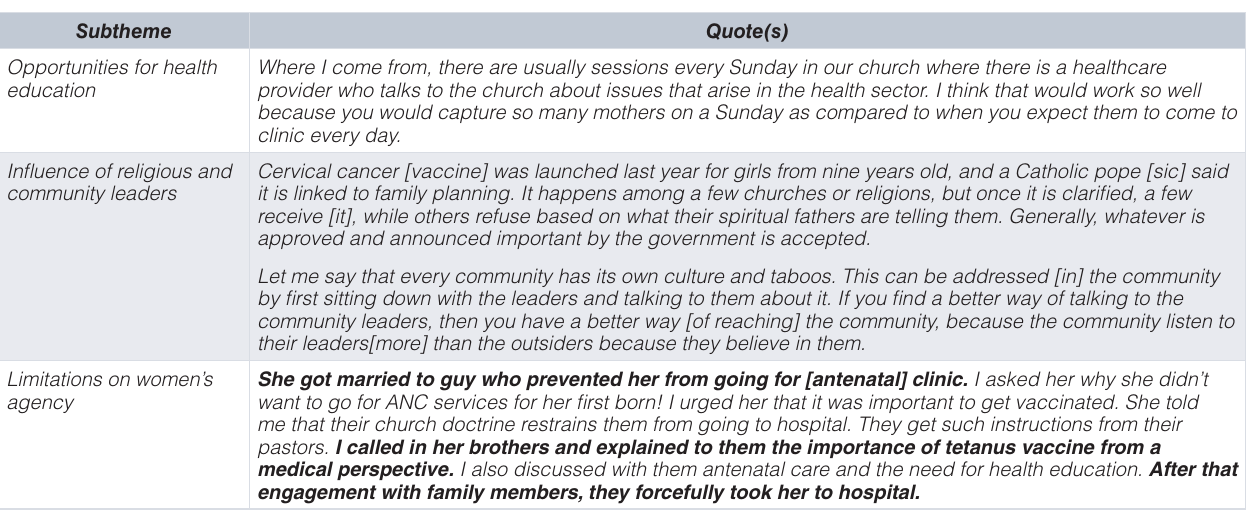
Table 2. Cultural, religious, and social factors influencing vaccine acceptance.